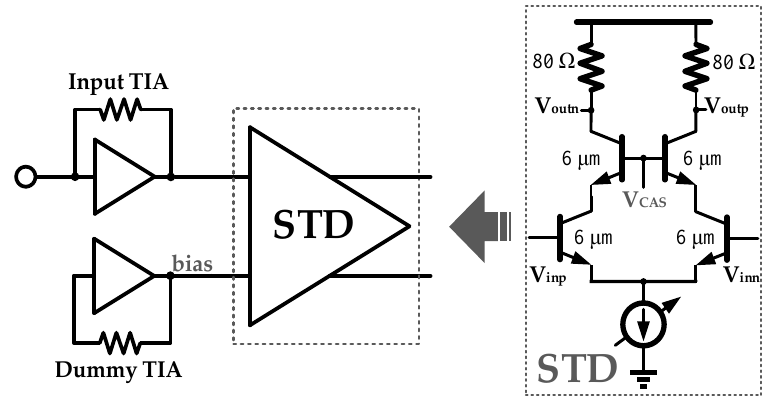
Figure 7. The single-ended–differential amplifier (STD) stage block diagram.